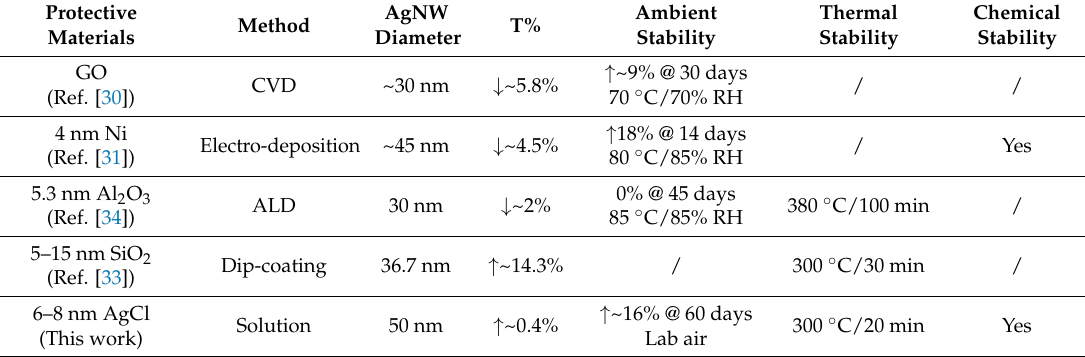
Figure 8. Sheet resistance variation of AgNW TCFs of 50 nm-thick AgNWs in the thermal test: influence of FeCl 3 -DS treatment time. Table 1. Comparison of AgNW based hybrid films with previous studies.